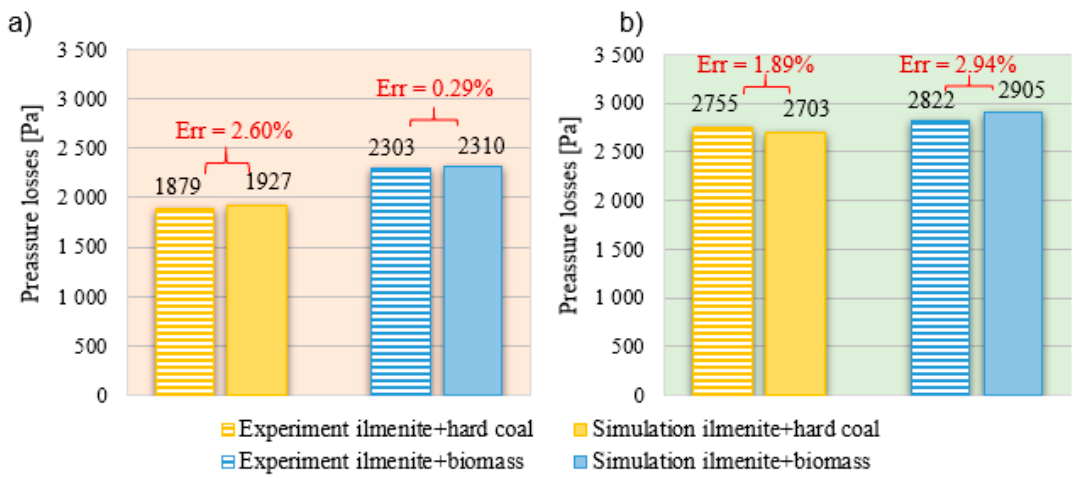
Figure 9. Pressure drop in the fluidized bed ( a ) AR ( b ) FR.